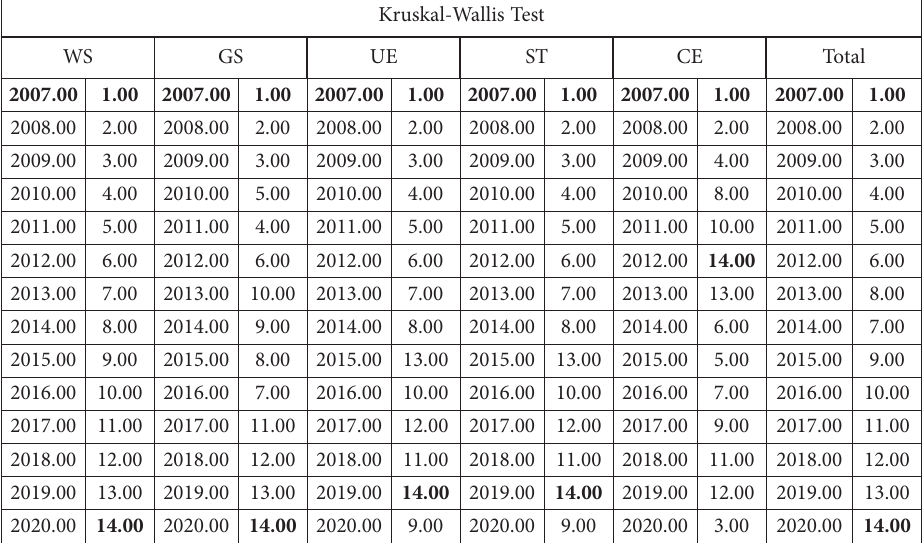
Table 9. Kruskal-Wallis test